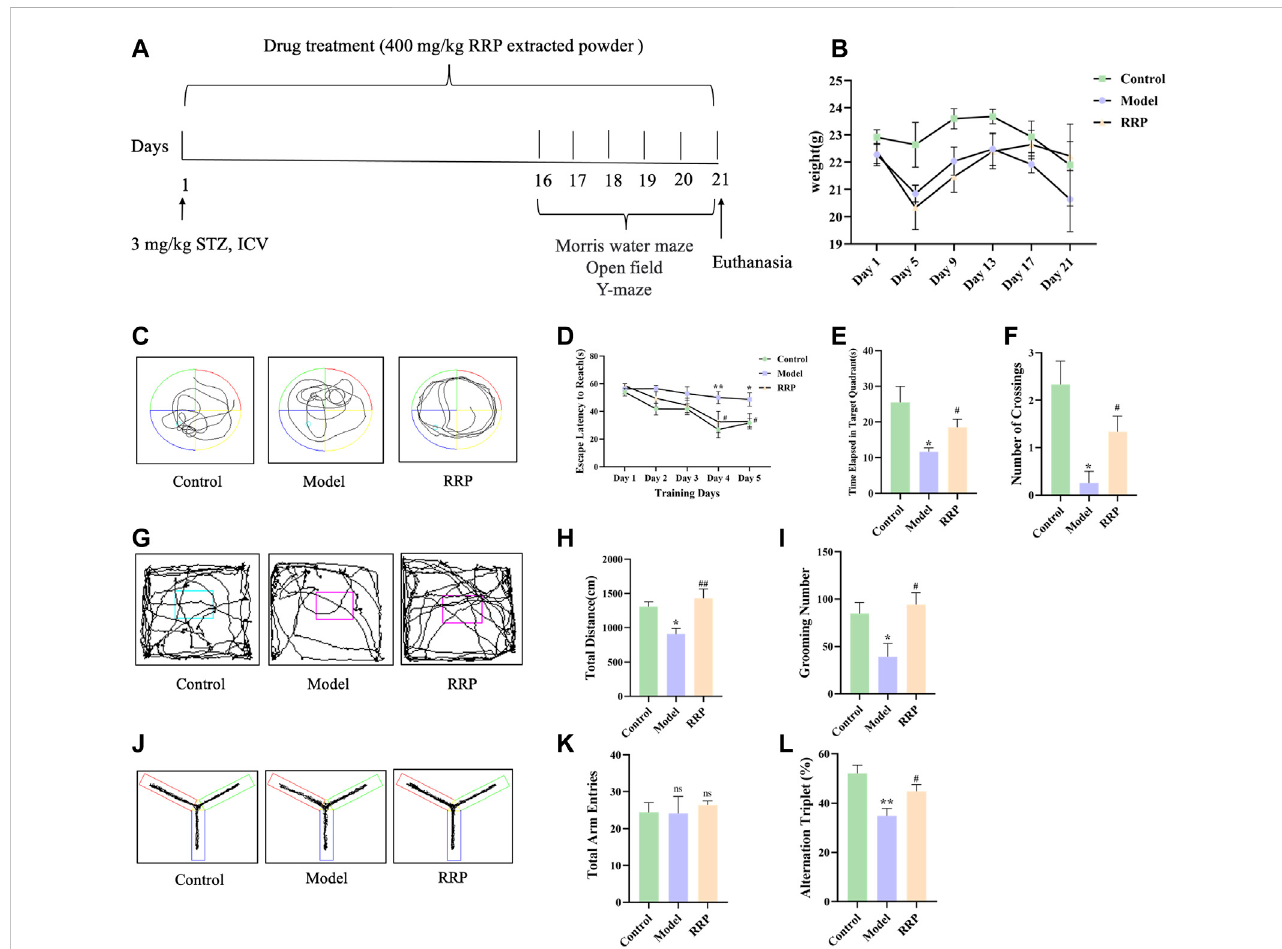
FIGURE 1 Experimentaldesign,theweight changes andbehaviorexperiments ofmice. (A) 3 mg kg − 1 STZwas injectedintothelateralventricleto induce ADmodel mice. Mice of control group were injected with an equal volume of sodium citrate buffer. Mice in RRP-treated group were continuously gavaged with 400 mg/kg RRP for 21 days. The control and model groups were gavaged with equal volumes of PBS. Behavior tests were performed on the last 5 days. Tissueswerecollectedafter euthanasia. (B) .Theweight changesofmiceduringtheexperiment. (C) .Morriswatermazeswimmingtrajectoriesofmicein each group; (D) . Morris water maze evasion latency; (E) . Time elapsed in target quadrant in the Morris water maze; (F) . The number of platform crossings in Morris water maze; (G) . Open fi eld activity trajectories of mice in each group; (H) . Total distance; (I) . Grooming times; (J) . Y maze activity trajectory of mice in each group; (K) . The total number of Y maze arm entries in each group; (L) Spontaneous altercountry accuracy of Y maze. * model group compared with the control group, # RRP group compared with the model group, same as in Figures 3 –